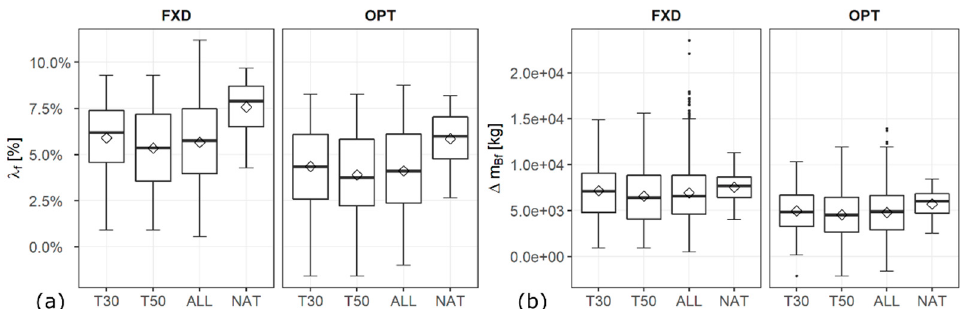
Figure 5. Comparison of the benefits for the different settings and studies. Relative efficiency metric ( a ), absolute efficiency metric ( b ); mean values (diamond).